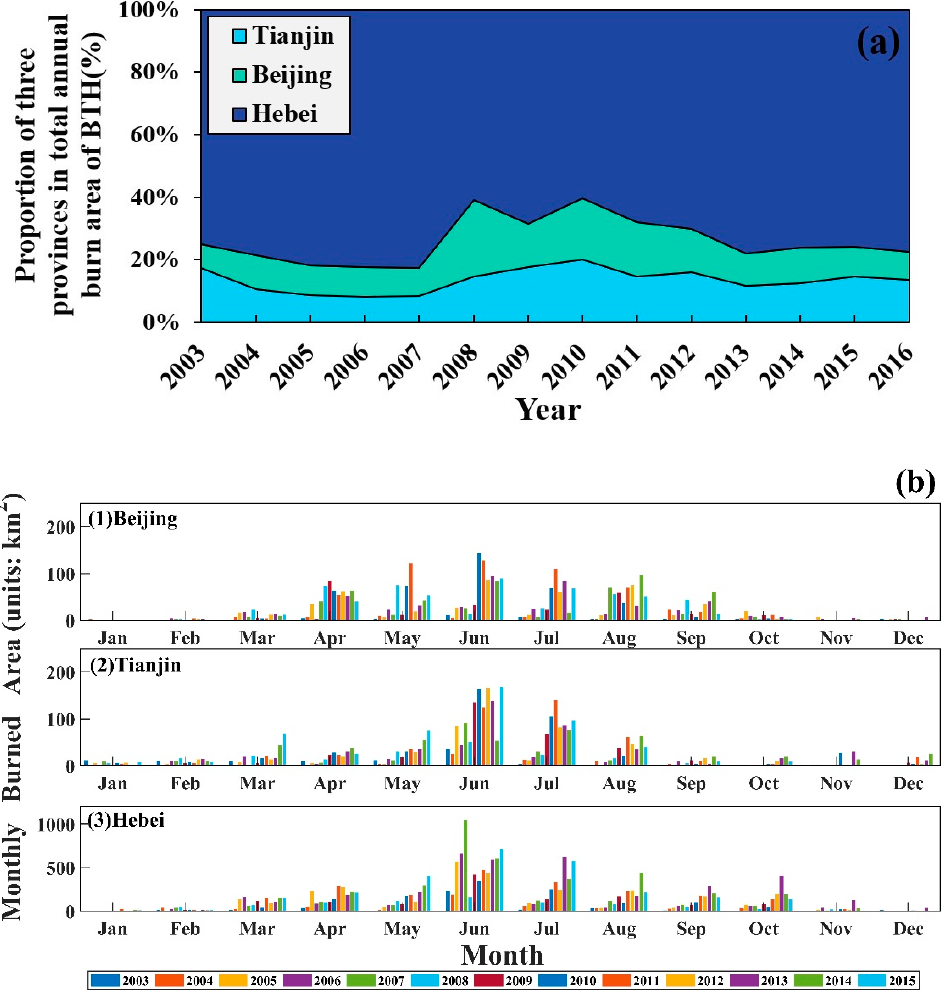
Figure 4. The annual ( a ) and monthly ( b ) variation in GFED4 burned area in different provinces from 2003–2016.